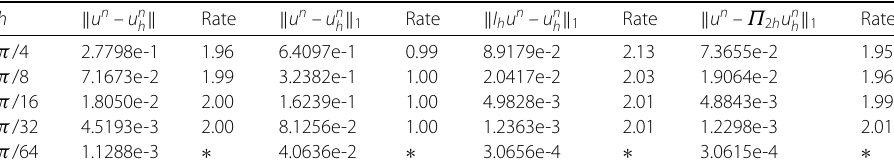
Table 5 Numerical errors and convergence orders in spatial direction with τ = 1 α = 0.1 at T = 1 for Example 2